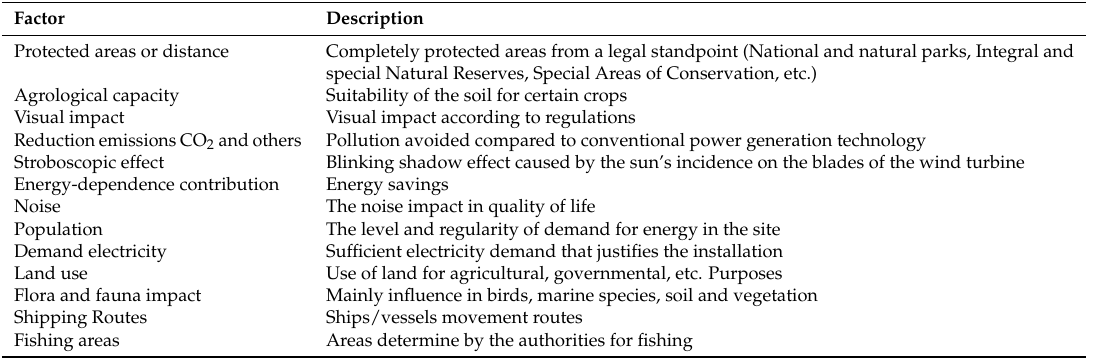
Table 3. Description of factors involved in the optimal location in the wind farms. Socio-environmental category.